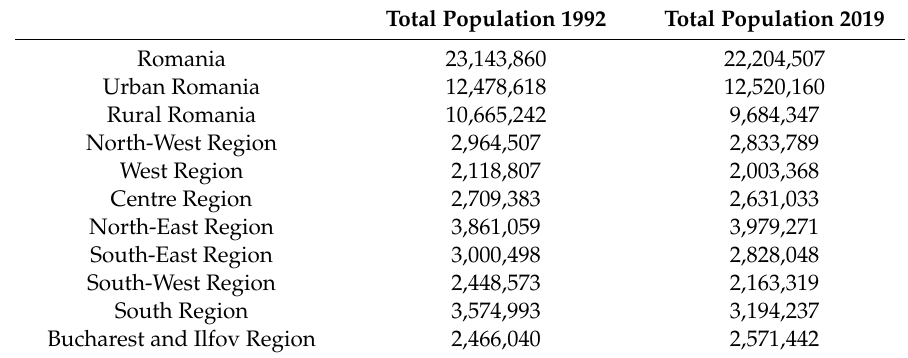
Figure 3. Map of Romania and its Development Regions. Taken and adapted from source: https: // en.wikipedia.org / wiki / Development_regions_of_Romania# / media / File:Regiuni_de_dezvoltare.svg. Table 2. The population of Romania and the main Development Regions [26].